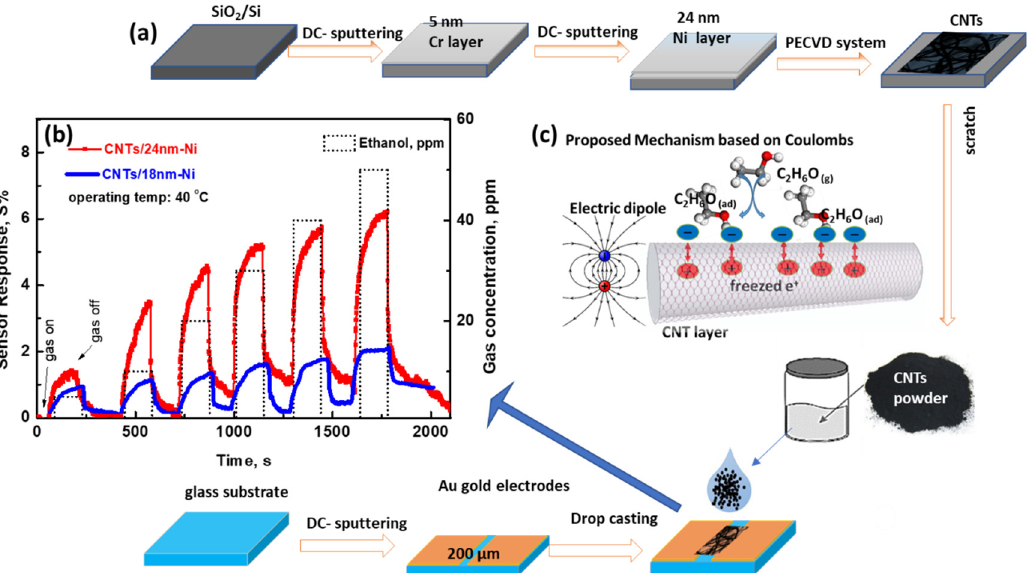
Figure 4. ( a ) Scheme of the synthesis of CNTs and sensing device fabrication; ( b ) signal as a function of time at different gas concentrations for the sensor prepared by 18 and 24 nm of Ni catalyst layer; and ( c ) the C 2 H 5 OH sensing mechanism. Figures reproduced with permission from [107].